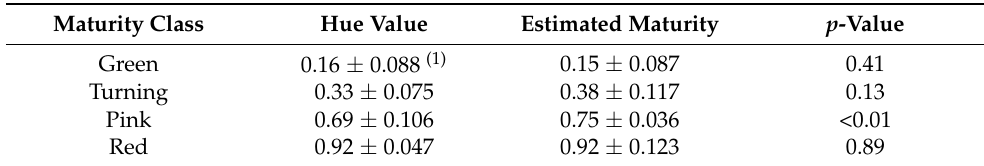
Table 2. Analysis of the estimated tomato maturity, by comparing the hue value with the maturity class.